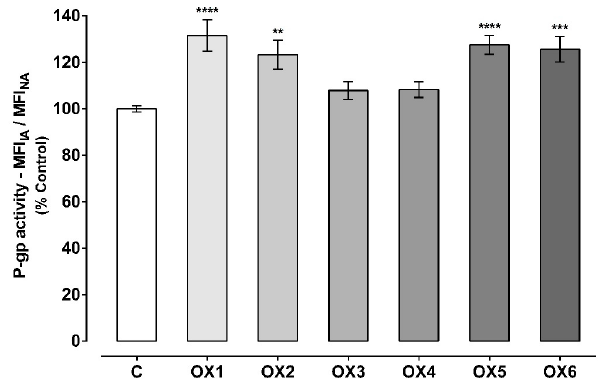
Figure 4. P-glycoprotein (P-gp) activity assessed through the Rhodamine 123 (Rho 123) accumulation in the presence of the six tested oxygenated xanthones (OX 1–6, 20.0 µ M), during the Rho 123 accumulation phase. Results are presented as mean ± SEM from six independent experiments (performed in triplicate). Statistical comparisons were made using one-way ANOVA, followed by Dunnett’s multiple comparisons test [** p < 0.01; **** p < 0.0001 vs. control (0 µ M)].